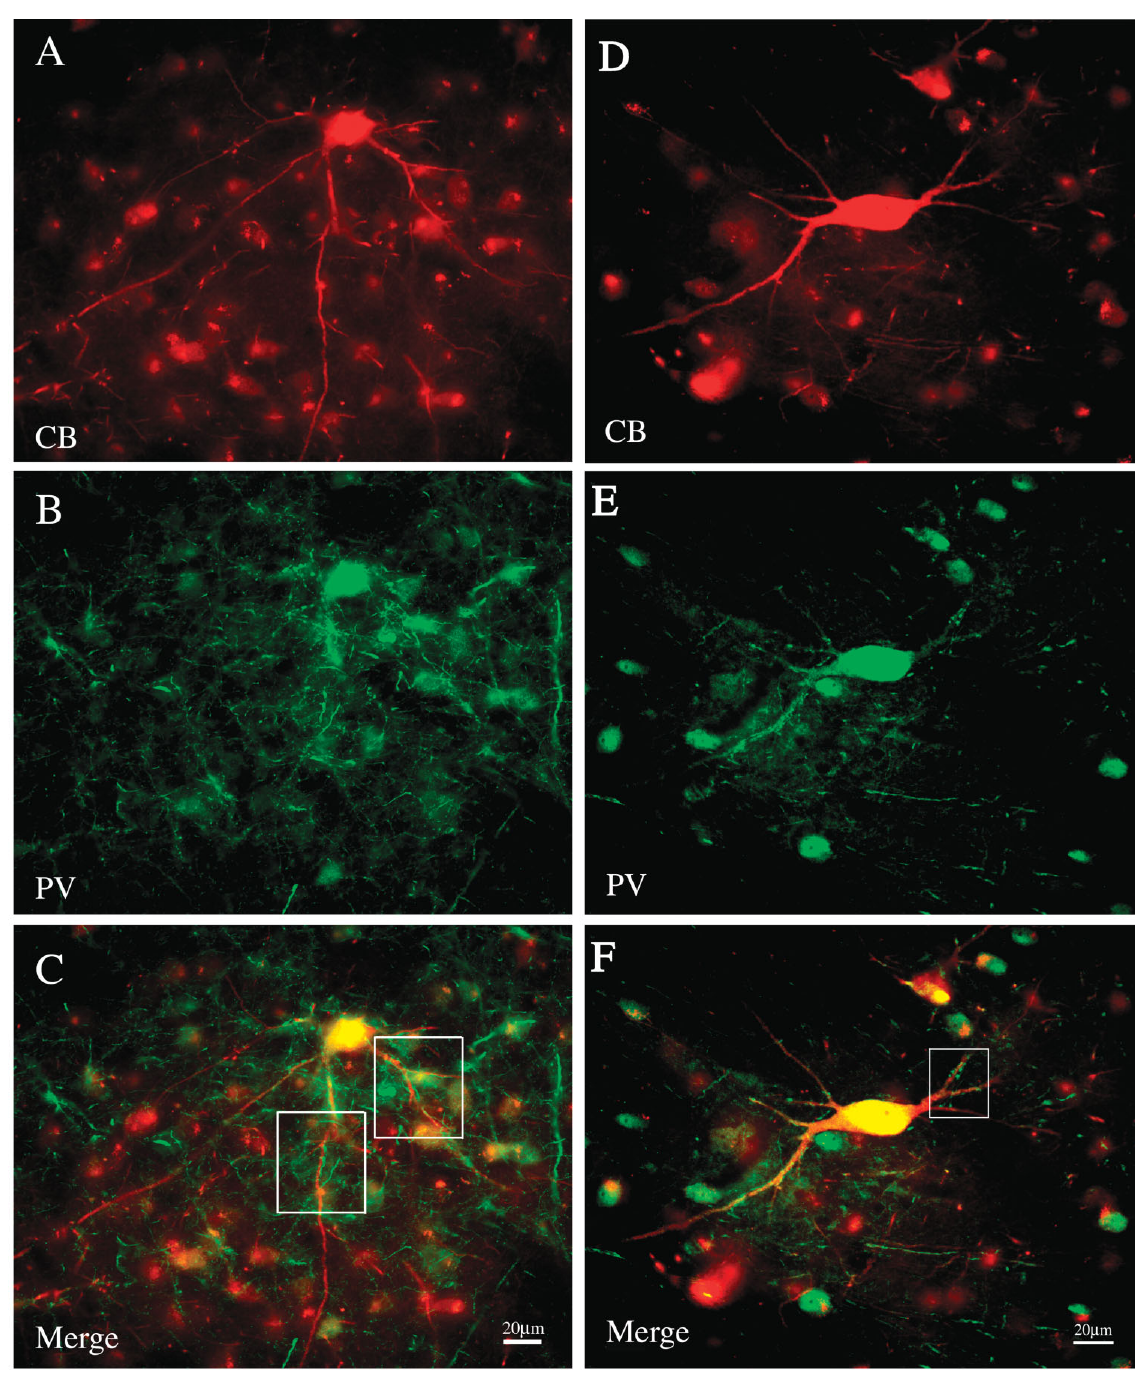
Figure 5. A subset of giant neurons is positive for both CB and PV . ( A ) A field of CB + neurons from PI, including one giant neuron (immunofluorescense for Alexa-594). ( B ) Same section reacted for PV (immunofluorescense for Alexa 488). ( C ) Merged image directly demonstrates that the giant neuron is both CB + and PV + . Boxed segments are shown at higher magnification in Figure 8 . ( D ) Giant CB + neuron from another animal. ( E ) Same section reacted for PV. ( F ) Merged image directly demonstrates that the giant neuron is both CB + and PV + . Boxed segment is shown at higher magnification in Figure 8 .